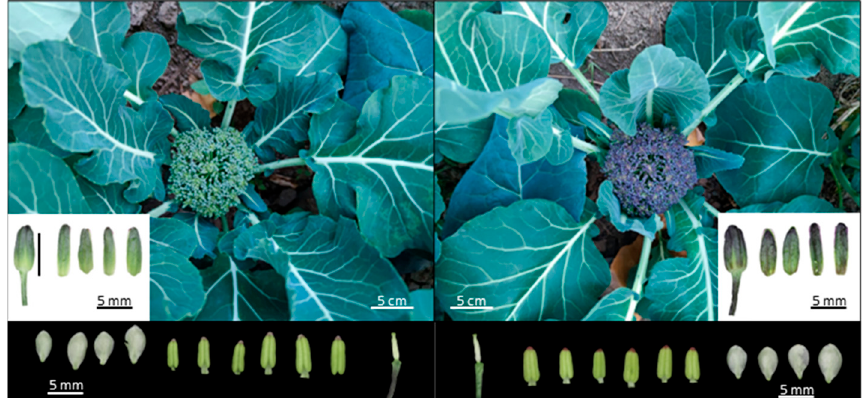
Figure 1. Phenotypic characteristics of GB767 ( left ) and PB767 ( right ) broccoli NILs. The florets were further dissected to compare their color differences between different floral organs. Photos of flower buds and their sepals of GB767 and PB767 are shown on the bottom left and right, respectively. Photos of the petals, stamens pistils, styles, and pedicels of two NILs are shown below.